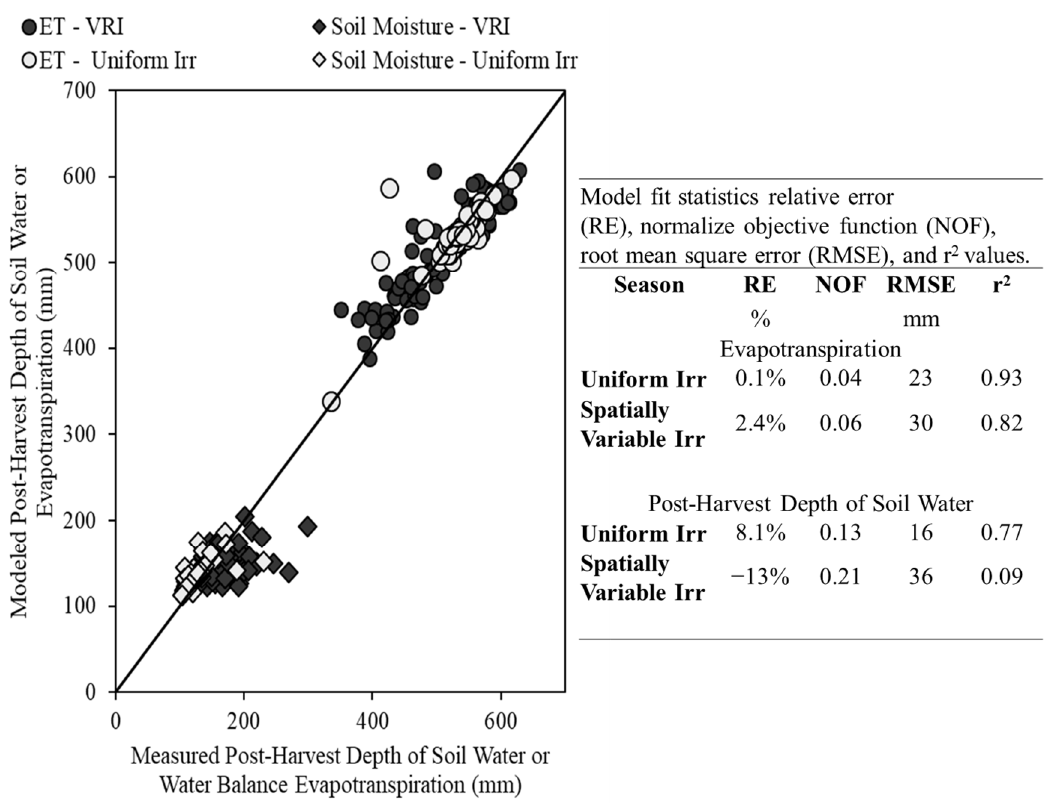
Figure 3. Modeled vs. measured season-long evapotranspiration or depth of post-harvest soil water in the 1.2 m deep soil profile for cropping seasons with uniform irrigation (2016) or spatially variable irrigation treatments (2017). A superimposed 1:1 line is added to indicate under and over prediction.